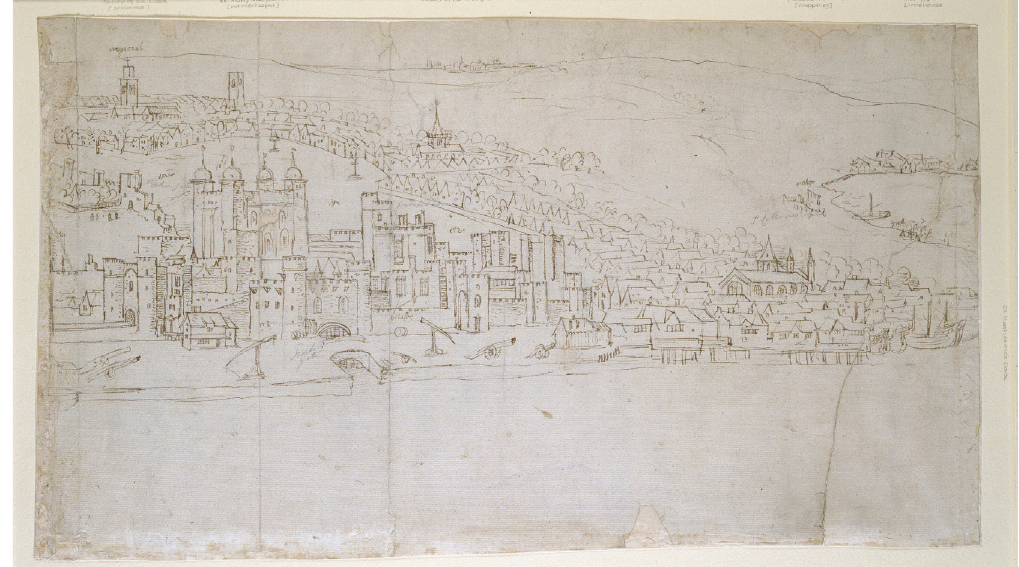
Fig. 4. Anthonis van den Wyngaerde, the Tower, part of the artist’s London Panorama, 1540s. Oxford, Ashmolean Museum [Accession Number: WA1950.206.11]. Drawing in pen and ink. Image © Ashmolean